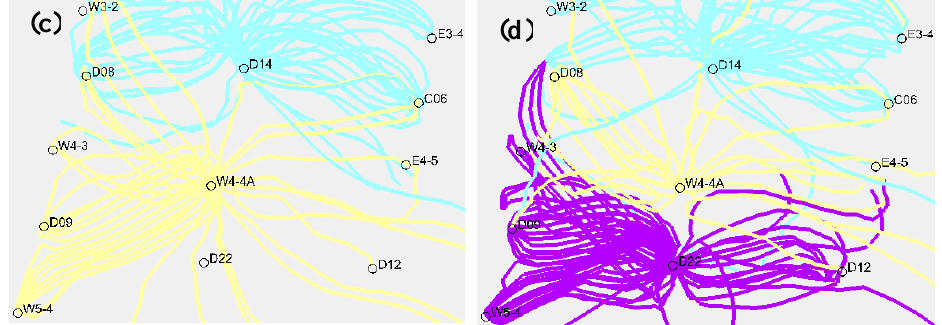
Figure 11. The streamline field of ( a ) un-injected polymer, ( b ) injected polymer, 0.045PV, ( c ) injected